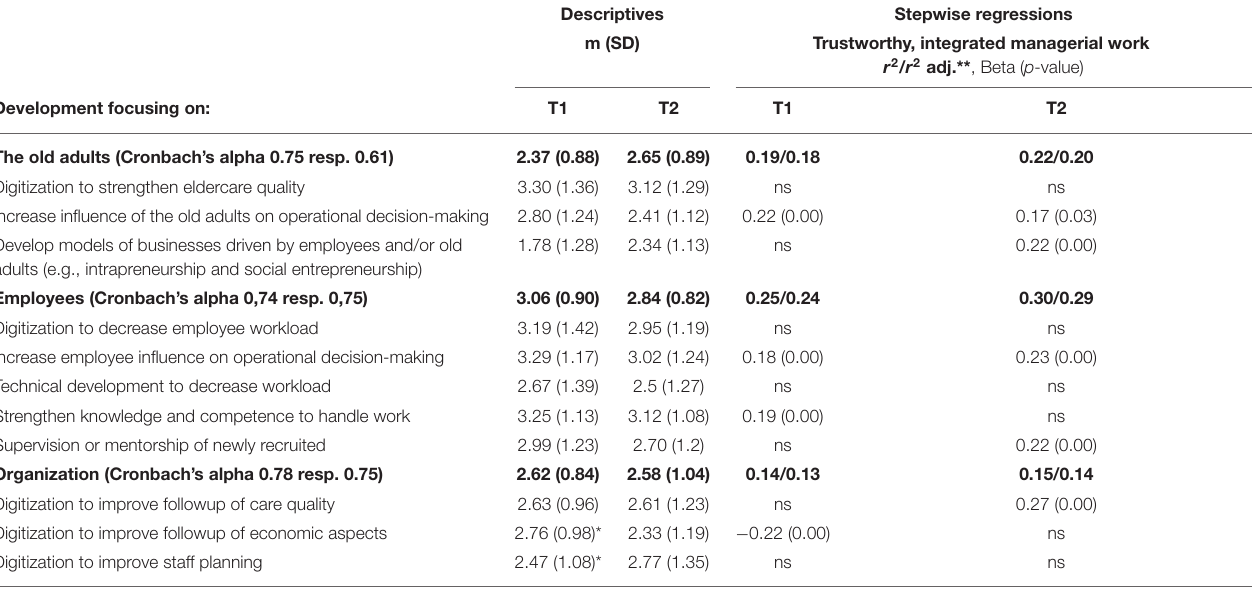
TABLE 4 | Active development work at eldercare units, for the purpose of strengthening resources for the capabilities of the old adults, employees, and eldercare organizations, and correlation with FLMs’ trustworthy, integrated managerial work; p > 0.1 considered non-significant (ns).